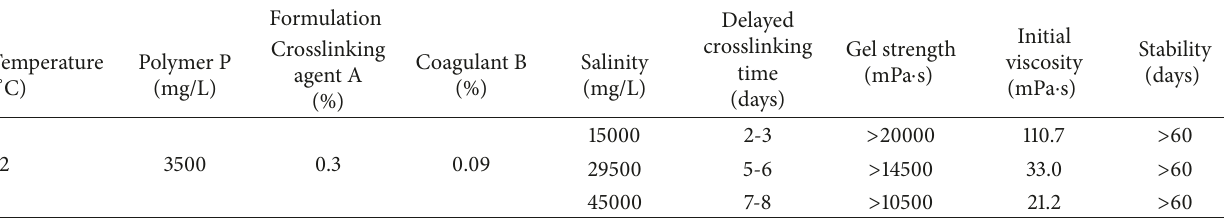
Table 2: The gelling performance of the ABP system at different salinities.